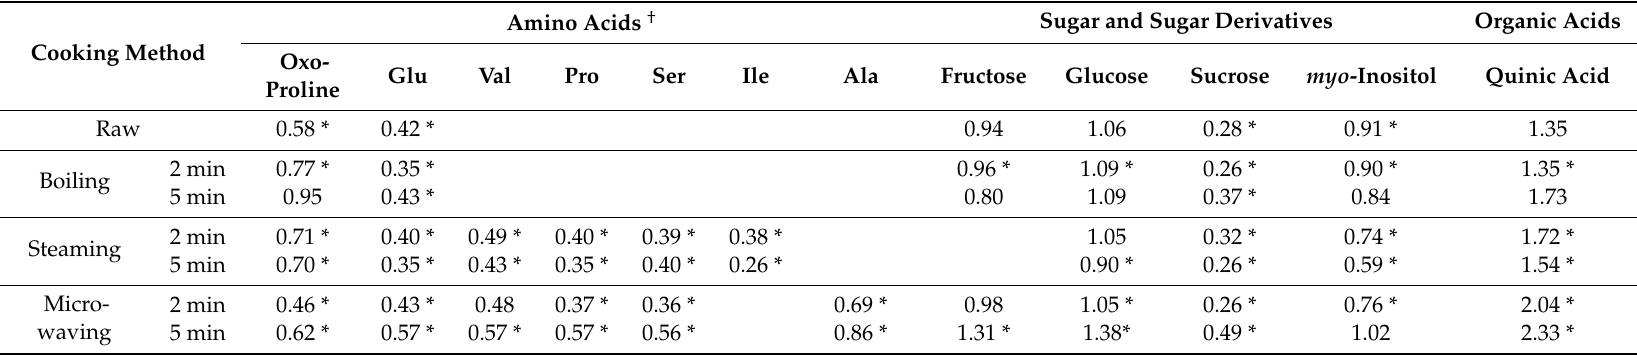
Table 1. Fold changes of primary metabolites in MeJA-treated ‘Green Magic’ compared to untreated broccoli under the same cooking treatment. Amino Acids † Sugar and Sugar Derivatives Organic Cooking Method